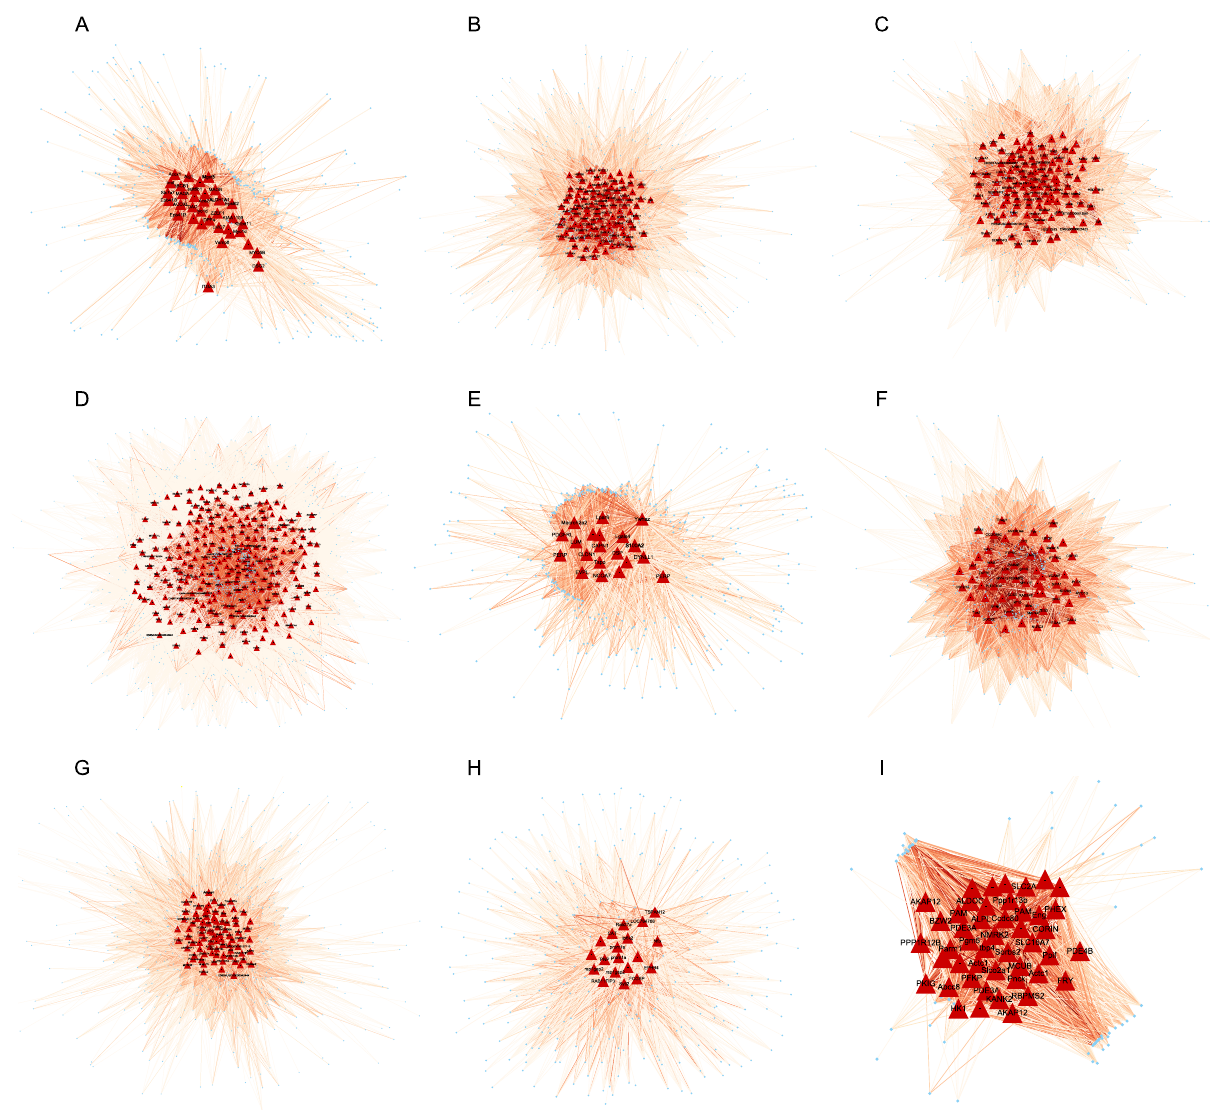
Figure 3. Weighted gene co-expression network of modules significantly correlate with tissues. The genes in network are not illuminated when the weight is less than 0.1. The triangle represents hub genes, which is statistically analyzed by WGCAN using cutoff of P value < 1e−8 and kME > 0.85 in each module. ( A ) Intestine. ( B ) Muscle. ( C ) Liver. ( D ) Ovary. ( E ) Skin. ( F ) Spleen. ( G ) Oviduct. ( H ) Stomach. ( I )